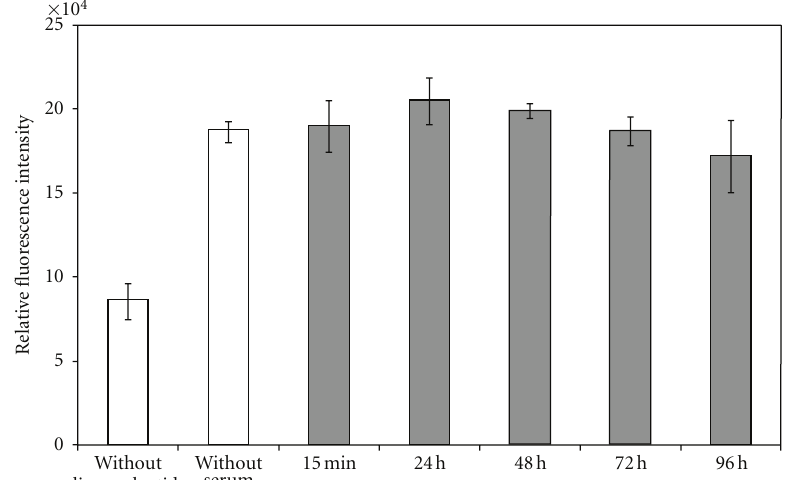
Figure 4: Stability against degradation by human blood serum of on diX AM-immobilized oligonucleotides. No significant degradation of oligonucleotides could be detected after 96h incubation in comparison to the samples without serum incubation ( P = 0 . 079, n =